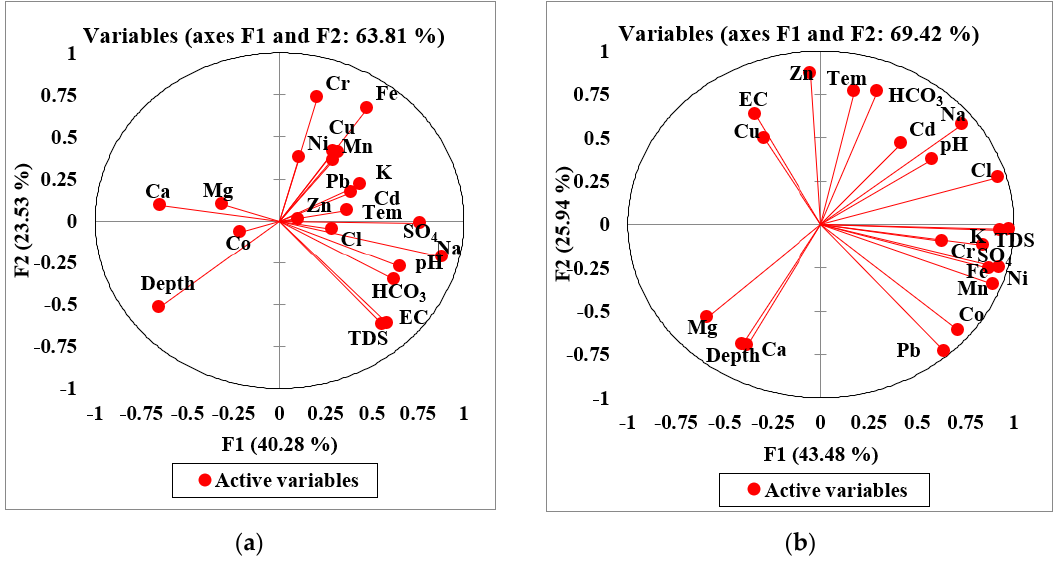
Figure 8. ( a ) PCA results of the first two factors FI and F2 in the groundwater and ( b ) mine water of the study area. Table 6. Principal component analysis multilinear regression results of the groundwater system in comparison with mine water in the Adenzai flood plain region, Pakistan. Bold values are different from others.